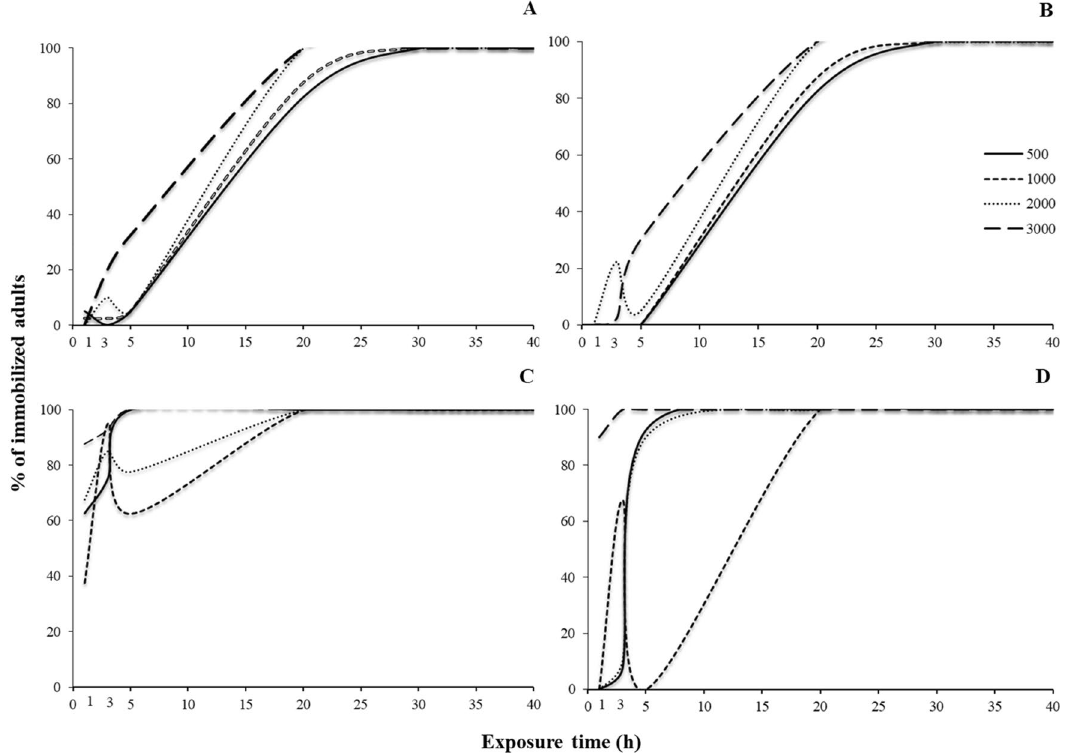
Figure 5. Percentage (%) of immobilized adults of resistant populations of R. dominica GA6 ( A ), S. oryzae 3TAB ( B ), O. surinamensis ASC11 ( C ) and T. castaneum BTS ( D ), for different exposure time (1, 3, 5, 20, 30 and 40 h) and different concentrations of phosphine (500, 1000, 2000 and 3000 ppm). The equations for each exposure interval for each species are presented in Table